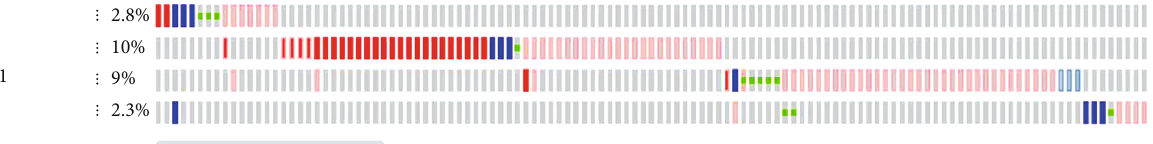
Figure 10: CA6 , CA9 , LCLAT1 , and CHDH gene expression and mutation